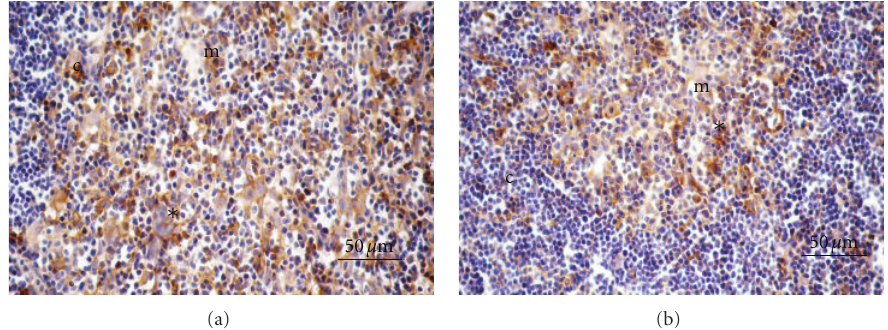
Figure 5: (a) CD11c+ thymic cells ( ∗ ) in control mice 2week. Thymic cortex (c) and thymic medulla (m). (b) CD11c+ thymic cells ( ∗ ) in exposed mice 2week. Thymic cortex (c) and thymic medulla (m).